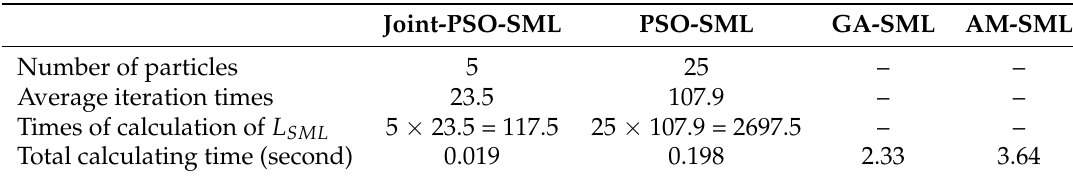
Table 5. Comparison of computational complexity of Joint-PSO, PSO, GA and AM for SML. Scenario: p = 8, q = 2, r = 2 ( non − coherent ) , N = 100, SNR = 0 dB, The ture DOA: 30 ◦ and − 15 ◦ , 30 independent trials, RMSE = 0.45.